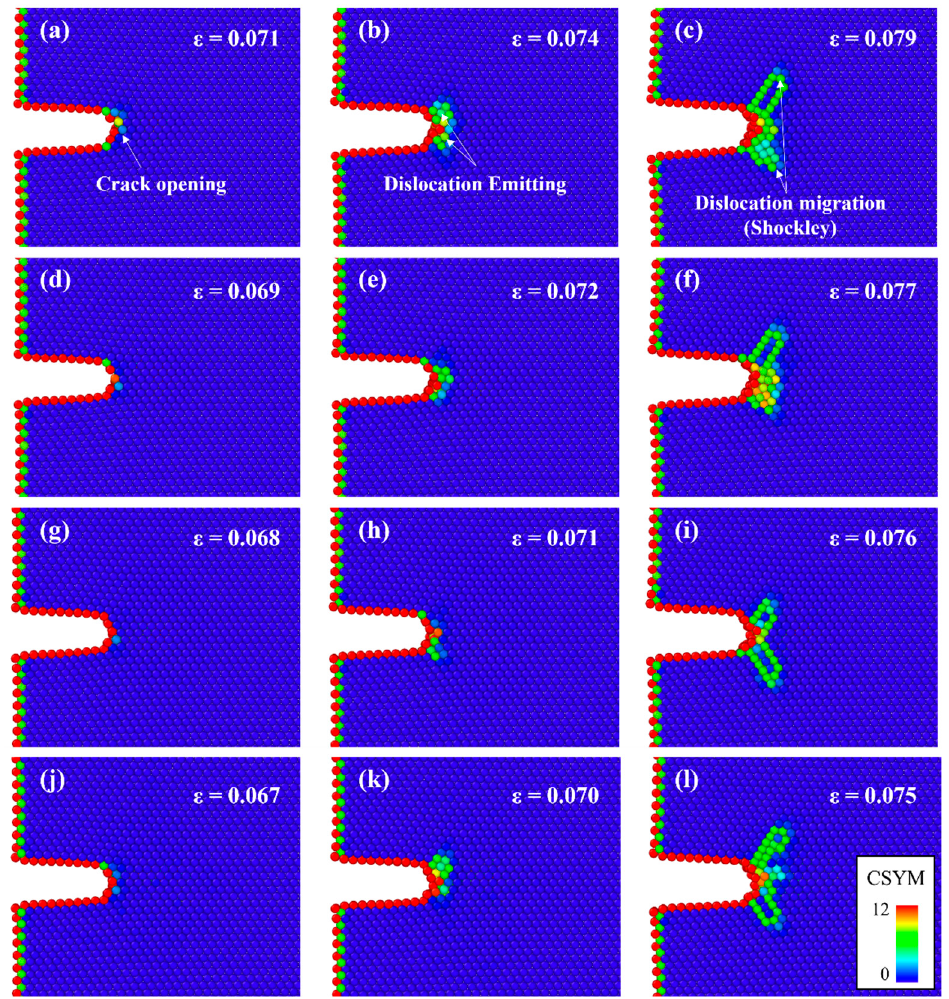
Figure 5. Atomic configurations of the cracked Al single crystal containing Mg – Si clusters with the radii of ( a – c ) 4, ( d – f ) 6, ( g – i ) 8, and ( j – l ) 9 Å. The different colors represent the CSYM parameters. The left column ( a , d , g , j ) shows the crack-opening strains; the middle column ( b , e , h , k ) shows the dislocation emitting strains; and the right column ( c , f , i , l ) shows the strain where Shockley dislocations sufficiently migrate.